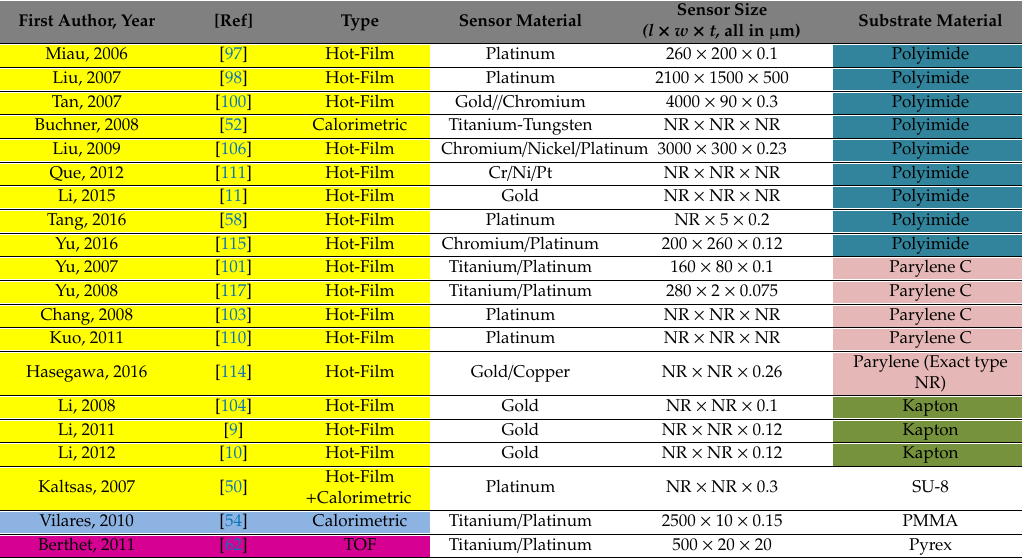
Table 2. MEMS Thermal Flow Sensors Fabricated on Polymer